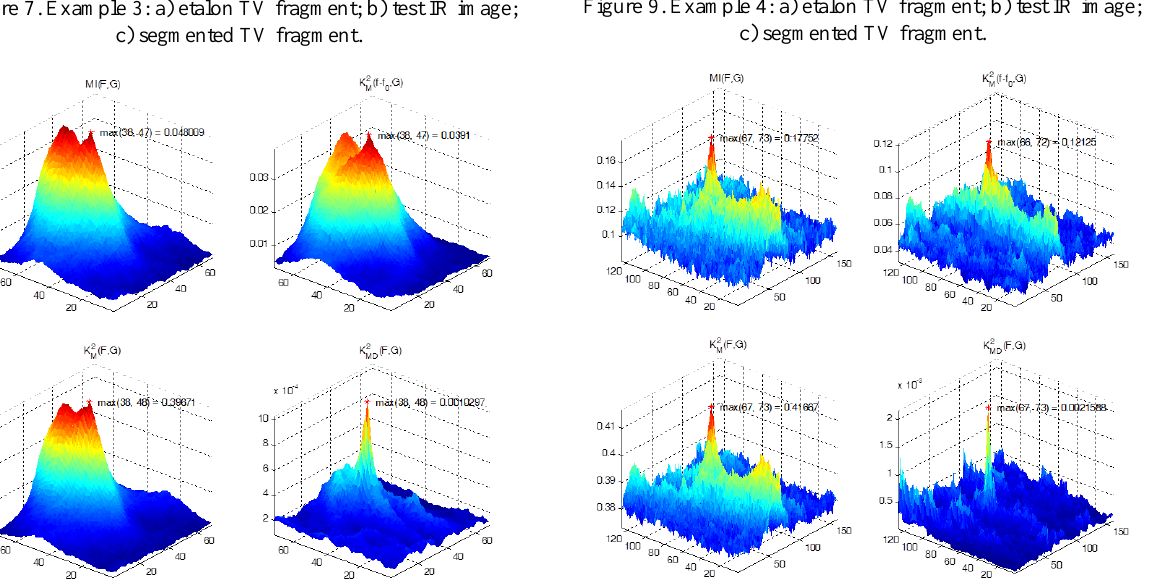
Figure 10. Correlation fields for TV-IR matching (Example